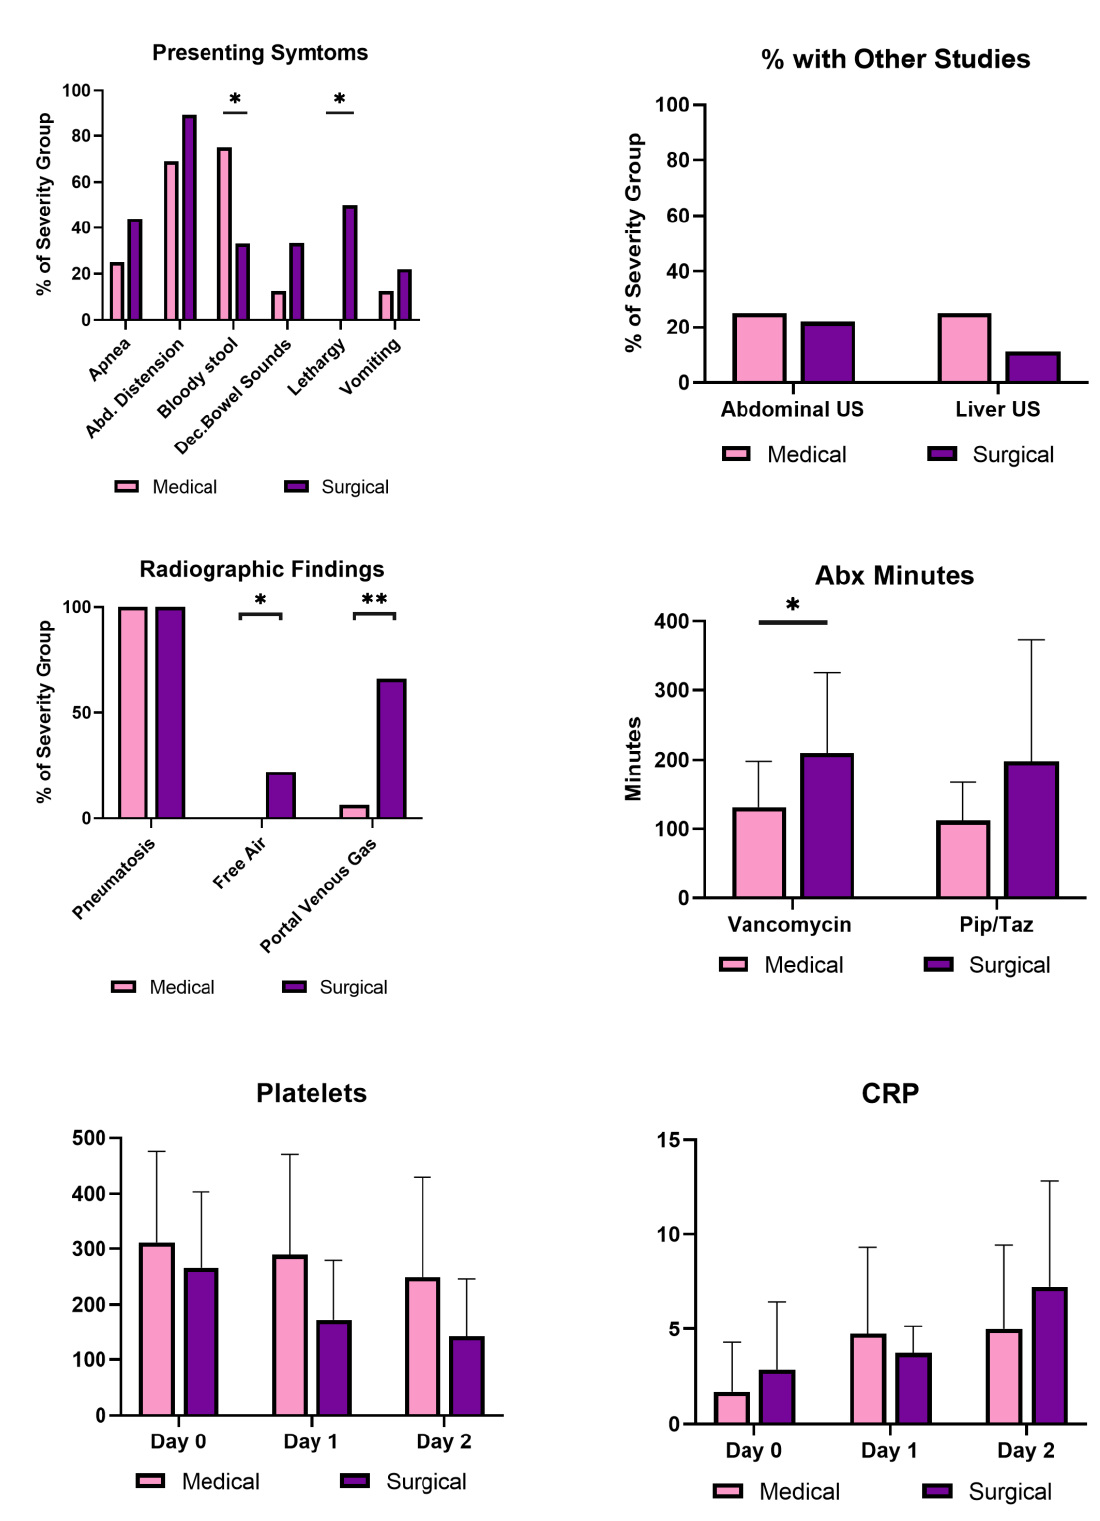
Figure 2. Comparison of clinical, laboratory, and antibiotic factors correlating to mild and severe NEC. Factors at diagnosis between medical (light) and surgical NEC (dark). C-reactive protein and platelet values: Day 0 is the day of NEC diagnosis. Fisher’s Exact test compared nominal variables, and t -tests compared continuous variables. Platelet units: 10 9 /L; CRP units: mg/dL. Significance was indicated by * p -value < 0.05, and ** p -value < 0.01.